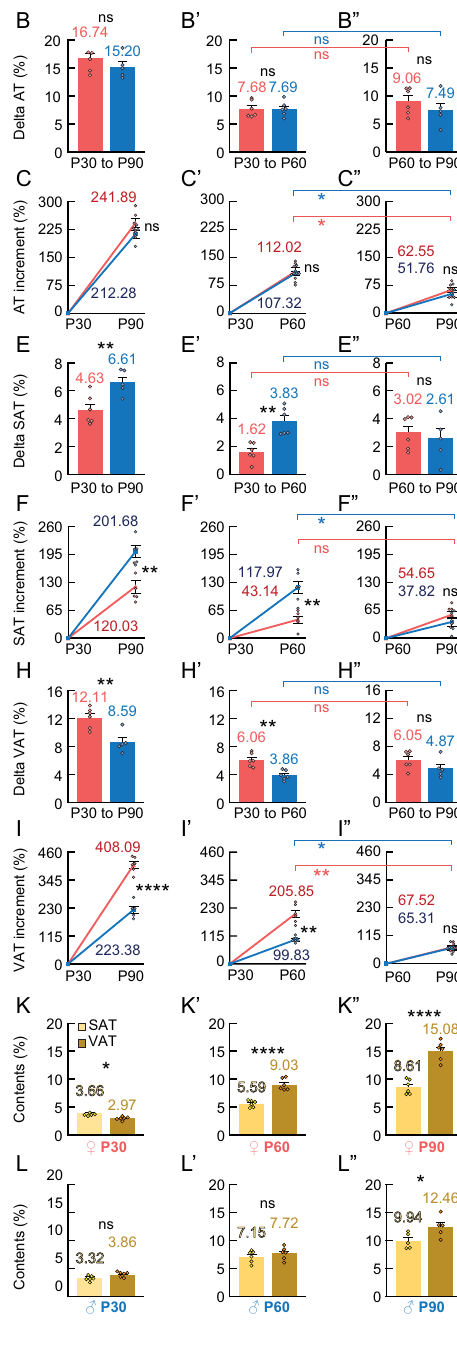
Figure 4. Female (red) and male (blue) comparisons of TA adipose contents. ( A ) Relative adipose contents (AT%). The split-plot ANOVA revealed a main effect of age in TA AT% (F 2,20 = 365.11, p < .01). ( B , B’ and B” ) Delta AT%. ( C , C’ and C” ) Percentual increment (%) of AT%. ( D ) Relative subcutaneous adipose contents (SAT%). The split-plot ANOVA revealed an interaction between age and sex in TA SAT% (F 2,20 = 5.93, p = .010), with a main effect of age (F 2,20 = 169.77, p < .01) and sex (F 2,20 = 5.93, p = .010). ( E , E’ and E” ) Delta SAT%. ( F , F’ and F” ) Percentual increment of SAT%. G) VAT%. The split- plot ANOVA revealed an interaction between age and sex in TA VAT% (F 2,14 = 12.08, p < .01), with a main effect of age (F 2,20 = 447.98, p < .01). ( H , H’ and H” ) Delta VAT%. ( I , I’ and I” ) Percentual increment of VAT%. ( J ) SAT%:VAT% ratio. The split-plot ANOVA revealed an interaction between age and sex in the TA SAT%:VAT% ratio (F 1.3,12.5 = 33.39, p < .01), with a main effect of age (F 1.25,12.52 = 37.91, p < .01). ( K–K” ) SAT% (yellow) versus VAT% (brown) comparisons of female rats (paired T-test). ( L–L”) SAT% versus VAT% comparisons of male rats (paired T-test). Statistics : Between-subjects effects were followed with Fisher’s LSD post-hoc. Paired T-test was used for within-subjects comparisons. Unpaired T-test was used in delta and increment between-subjects comparisons. Black stars (*): female versus male (or SAT% vs. VAT% in K–K” and L–L”). Blue symbols: within-male comparisons. Red symbols: within-female comparisons. Values represented as mean and SEM. Significance levels: * p < .05, ** p < .01, *** p < .001, **** p < .0001, ns: p >